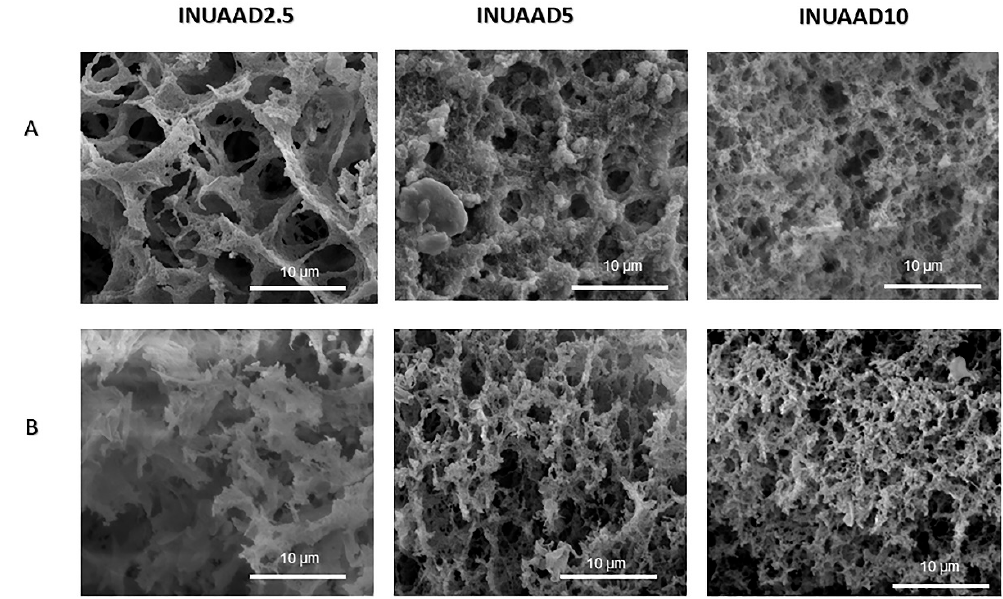
Figure 3. ( A ) SEM images of hydrogels (INUAAD2.5, INUAAD5, and INUAAD10) after immersion in acetate buffer for 2 days. ( B ) SEM images of hydrogels (INUAAD2.5, INUAAD5, and INUAAD10) after immersion in phosphate-buffered saline (PBS) for 2 days.